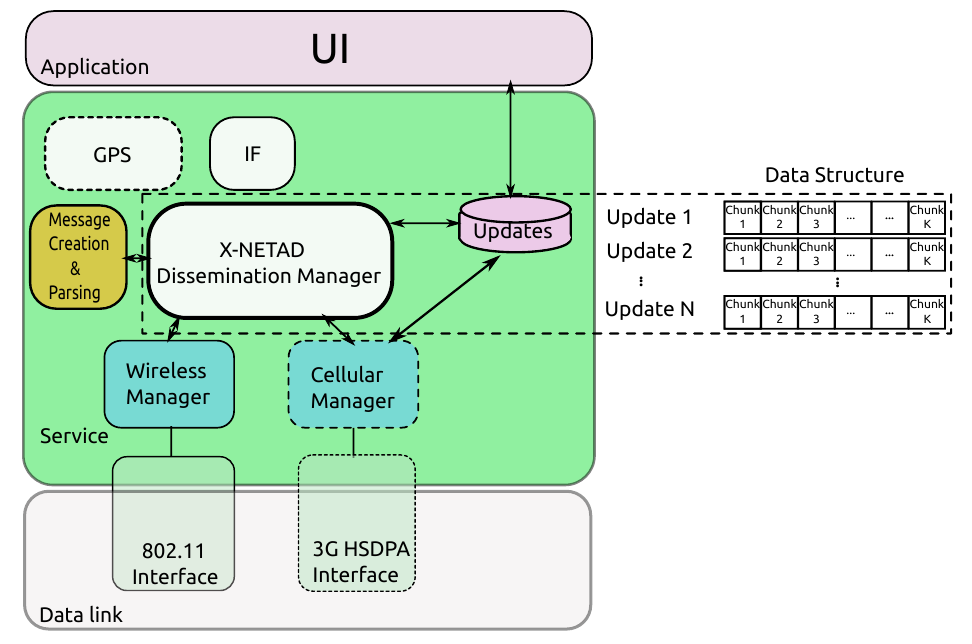
Figure 6. System architecture of an X-NETAD